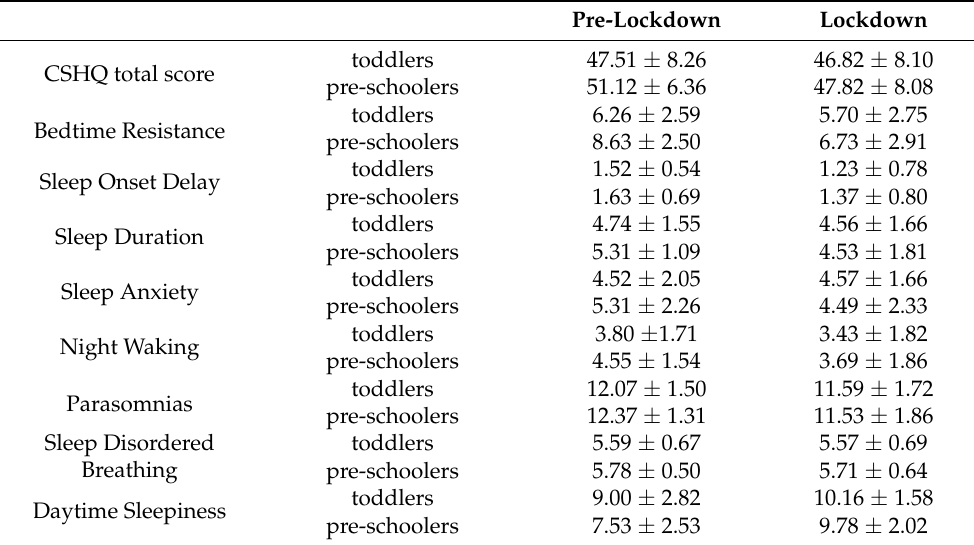
Table 3. CSHQ total score and sub-scores before and during the lockdown in toddlers and pre-schoolers.